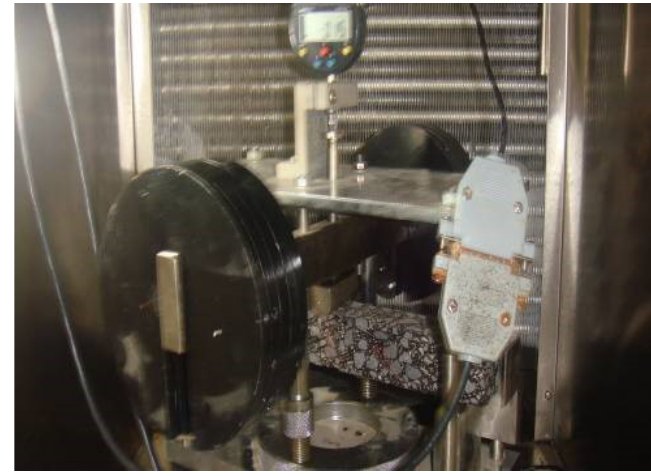
Figure 2. Small beam bend test for creeps.